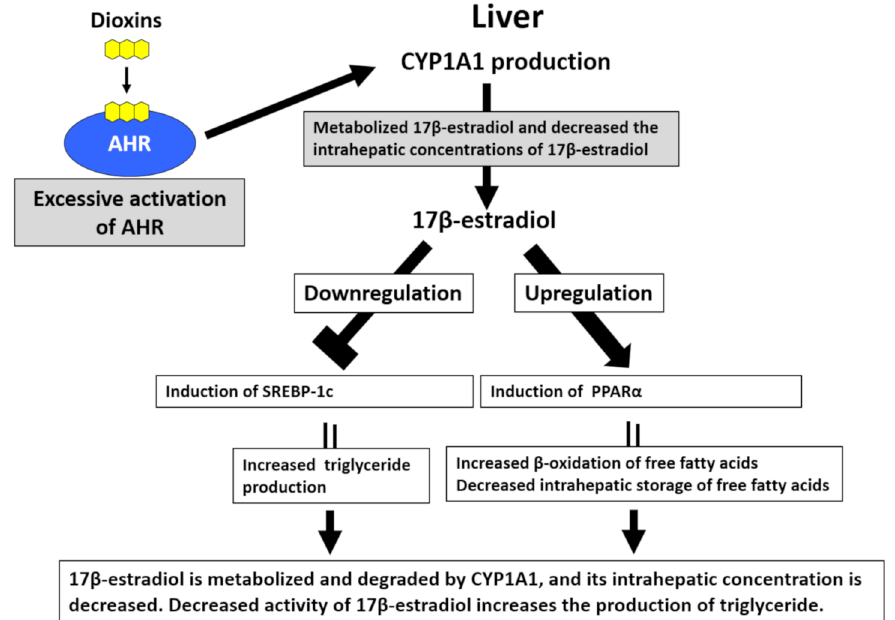
Figure 4. Excessive activation of aryl hydrocarbon receptor (AHR) by dioxins induces hypertriglyceridemia. In hepatocytes, sterol regulatory element-binding protein-1c (SREBP-1c) increases triglyceride production, and peroxisome proliferator- activated receptor- α (PPAR α ) upregulates the β -oxidation of free fatty acids and reduces the intrahepatic storage of free fatty acids. 17 β -estradiol inhibits the activity of SREBP-1c and enhances PPAR α activity, subsequently reducing triglyceride production. Hepatocytes abundantly express AHR. Upon the activation of AHR by dioxins, the expression of cytochrome P450 1A1 (CYP1A1) is augmented. CYP1A1 metabolizes 17 β -estradiol, thereby decreasing its intrahepatic concentrations and enhancing triglyceride